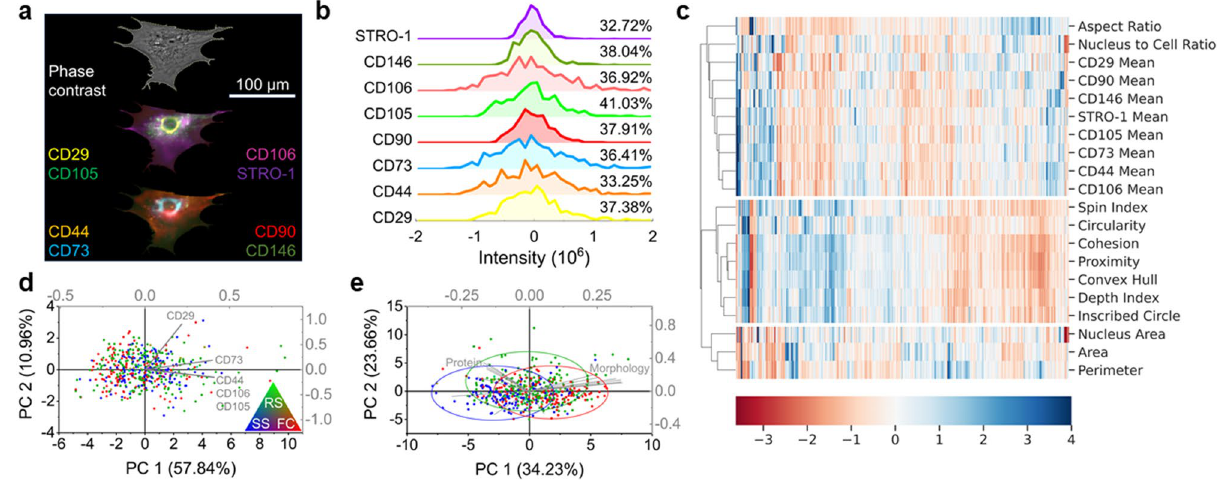
Figure 3. Multi-marker heterogeneity and gene expression-morphology correlation. ( a ) Example of cell outlining and marker distribution for single cell analysis. ( b ) Histogram of standardized intensity distribution of 500 single cells for 8 MSC markers. Percentages illustrate the standard deviation of each intensity distribution. Histogram was created by using OriginLab version 2019. ( c ) Hierarchical clustering of marker intensities and 12 different morphological features analyzed from outlined cells. Marker intensity and morphological features lead to distinct clustering patterns. The color represents the fold change with respect to the mean value for each row. Clustering analysis (heatmap) was performed using Python version 3.8 (seaborn). ( d ) Principal component analysis (PCA) biplot of mean intensity of all tested surface markers with loading vectors (grey) of the five